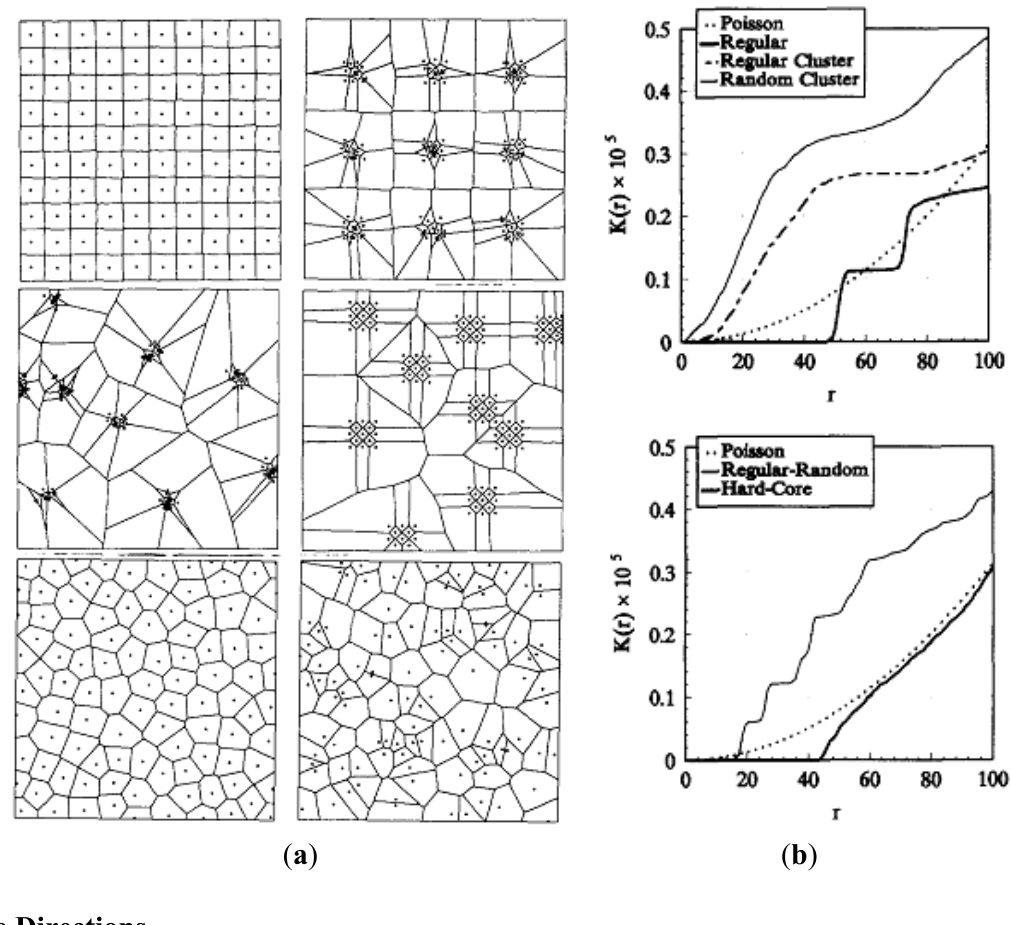
Figure 22. ( a ) Classification of point patterns (from top left to bottom right: regular, regular cluster, random cluster, regular-random, hard-core, Poisson); ( b ) second order intensity function K ( r ) for each of the distribution patterns shown in ( a )